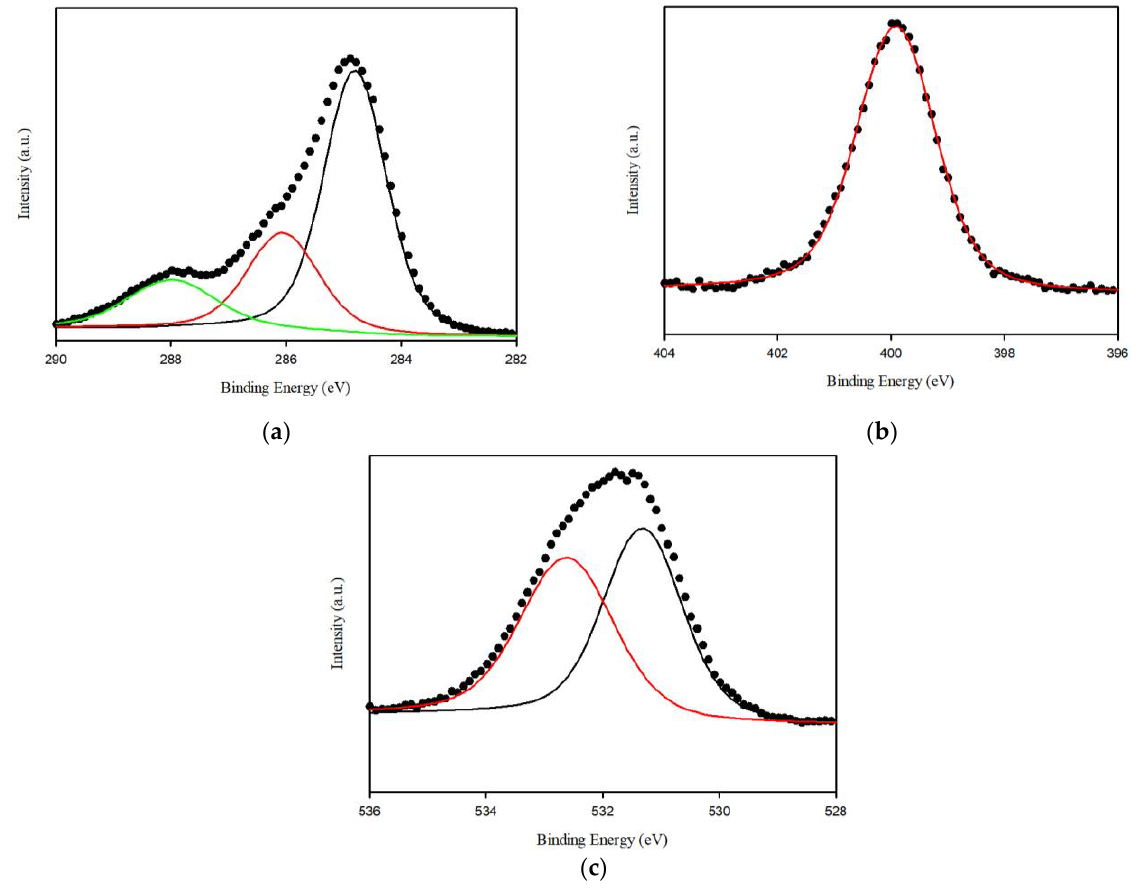
Figure 2. High resolution X-ray photoelectron spectroscopy (XPS) spectra for the surface of Spirulina platensis : ( a ) C 1 s ( b ) N 1 s and ( c ) O 1 s. Table 1. Pb removal capacities of various species of microalgae biomass reported in the literature